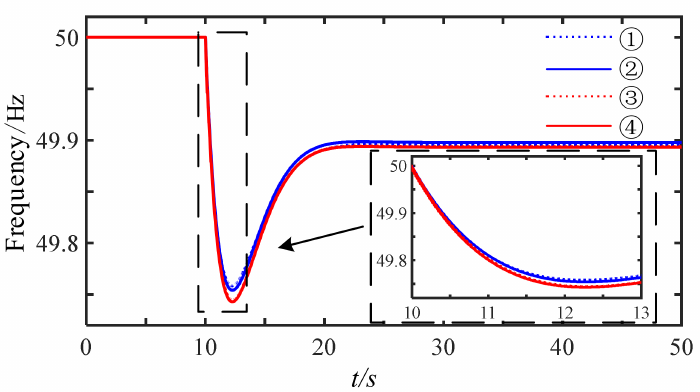
Figure 12. Comparison of system frequency characteristics between time-domain simulation and theoretical